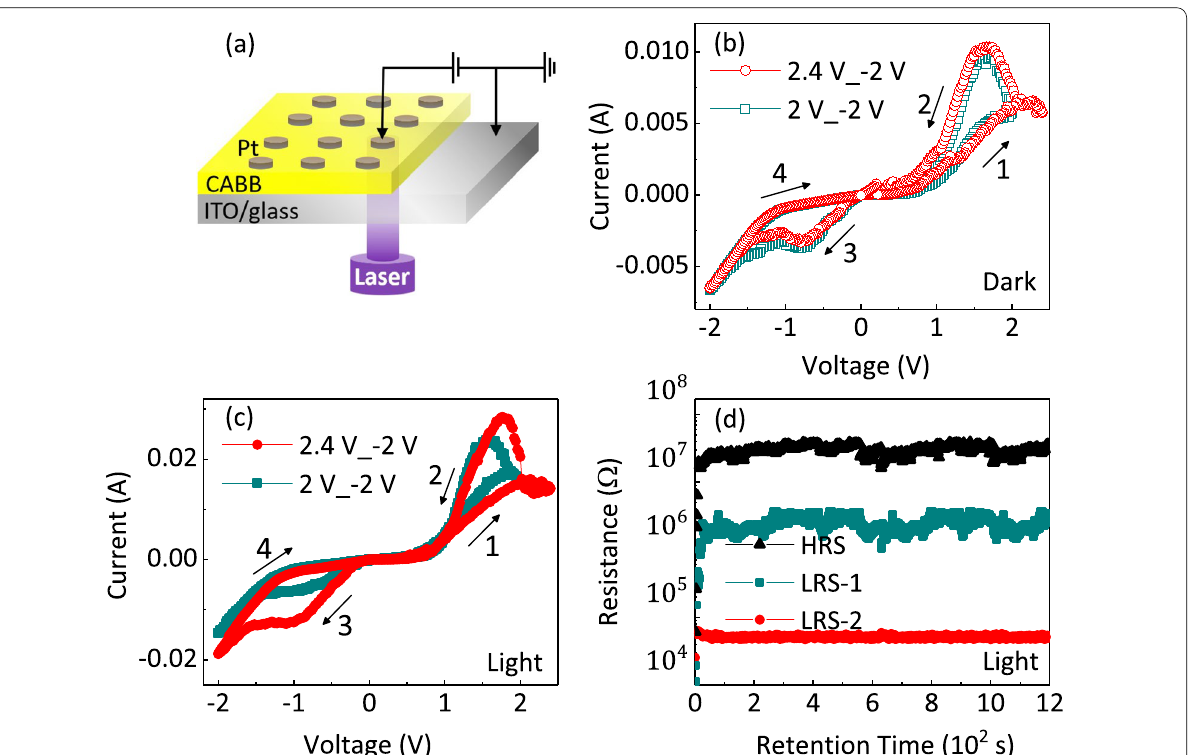
Fig. 3 a The configuration of the Pt/CABB/ITO/glass memory device. I–V curves for the device in dark ( b ) and under light irradiation ( c ), respectively. The numbers and arrows represent the voltage sweeping sequences and directions, respectively. d Time up to over 1200 s for HRS, LRS-1 and LRS-2 measurements under the light illumination of 445 nm at room